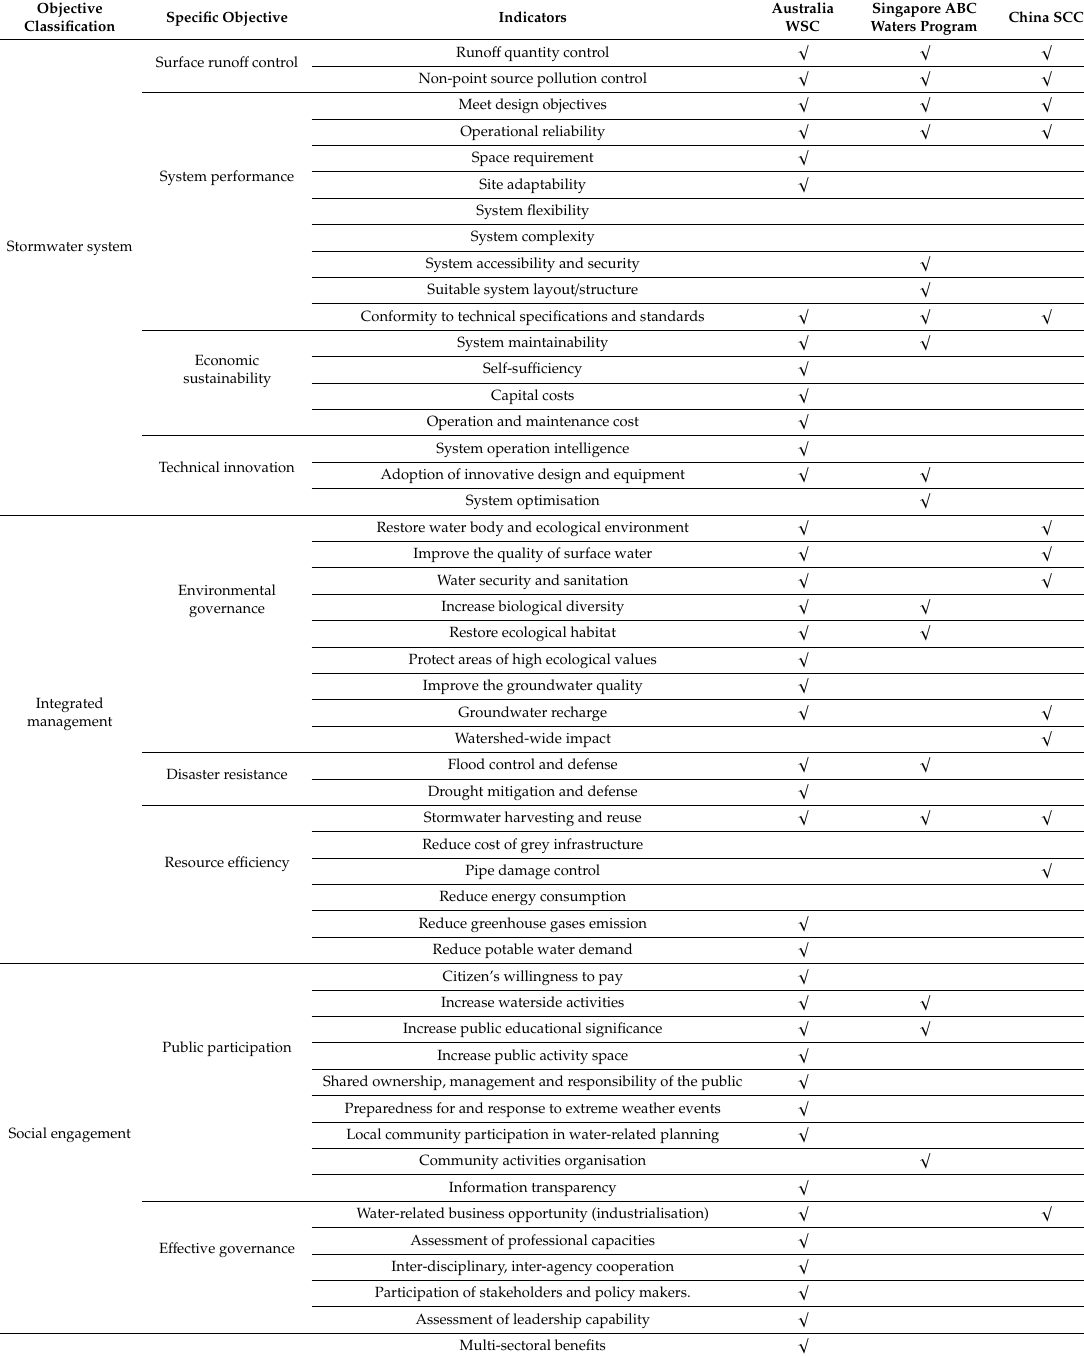
Table 2. SSWM indicators—comparison between Australia Water Sensitive Cities (WSC), Singapore Active, Beautiful, Clean (ABC) waters program, and China Sponge City Construction